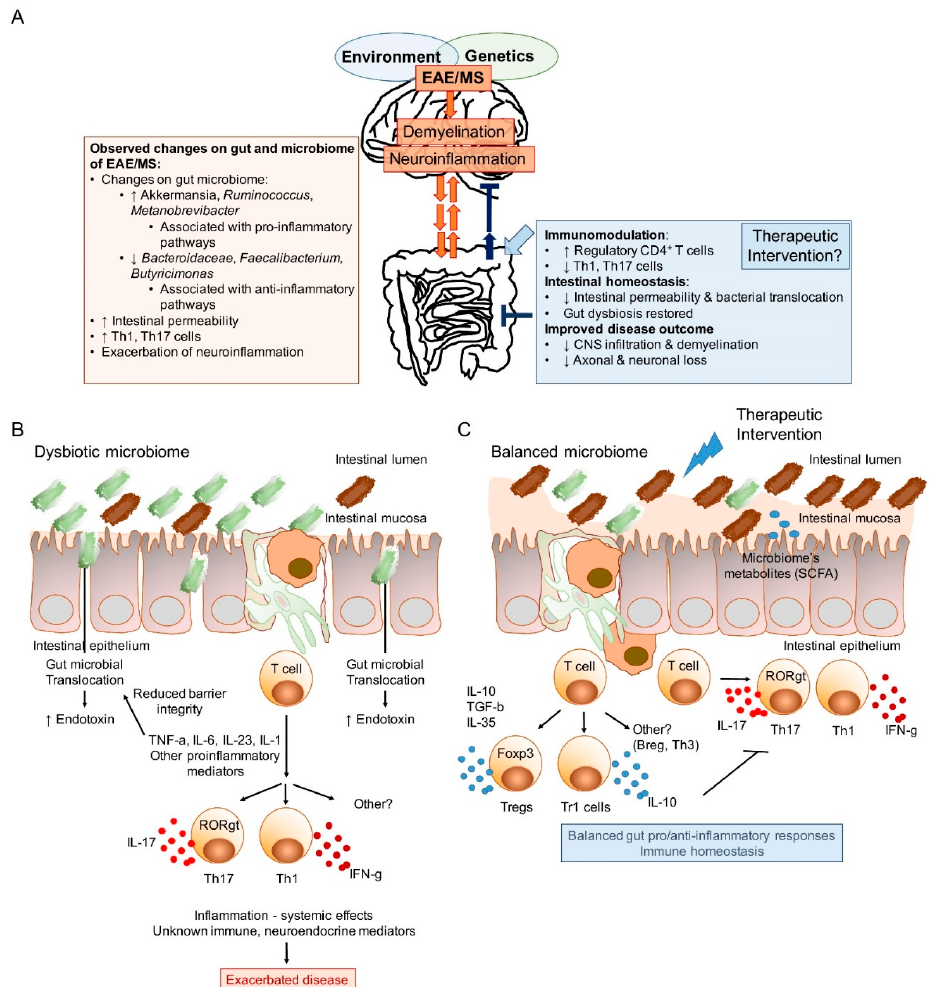
Figure 1. The bidirectional nature of the gut/brain axis, and the potential of the gut microbiome as a therapeutic route. ( A ) Proposed model of the gut microbiota as an amplifier of immune/inflammatory